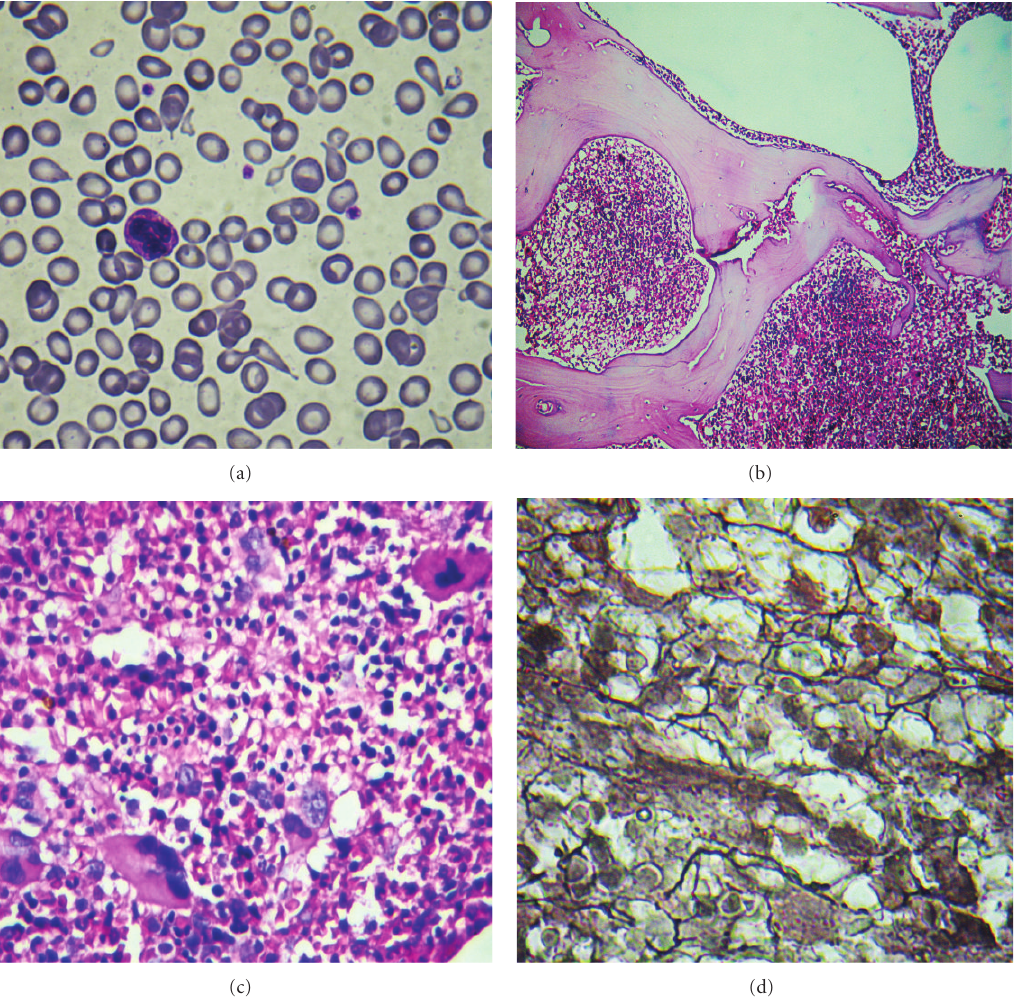
Figure 2: (a) Blood smear displaying anisocytosis and “tear drop” red cells. (b) BM biopsy showing hypercellular areas and distended marrow sinusoids. Megakaryocytes appear prominent even at low magnification. H&E 4x scanner. (c) BM biopsy illustrating increased number of atypical megakaryocytes against a hypercellular background. The “cloudy” nature of megakaryocyte nuclei is evident. H&E 45x. (d) grade 2/4 reticulin fibrosis highlighted by silver